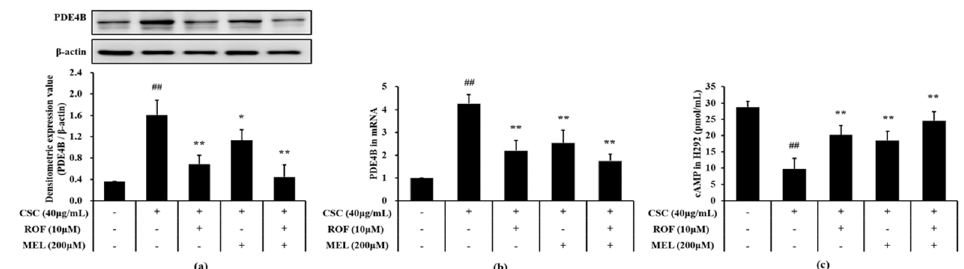
Figure 7. Melatonin decreased PDE4B and cAMP in CSC-stimulated cells. The protein and mRNA expression of PDE4B was determined in by immunoblotting and real-time PCR, respectively. cAMP level was determined in supernatant by ELISA. ( a ) PDE4B expression, ( b ) mRNA expression of PDE4B , ( c ) level of cAMP. This experiment was repeatedly performed three times. ## Significantly different from the non-treated cells, P < 0.01; *,** significantly different from the CSC-stimulated cells, P < 0.05 and P < 0.01.